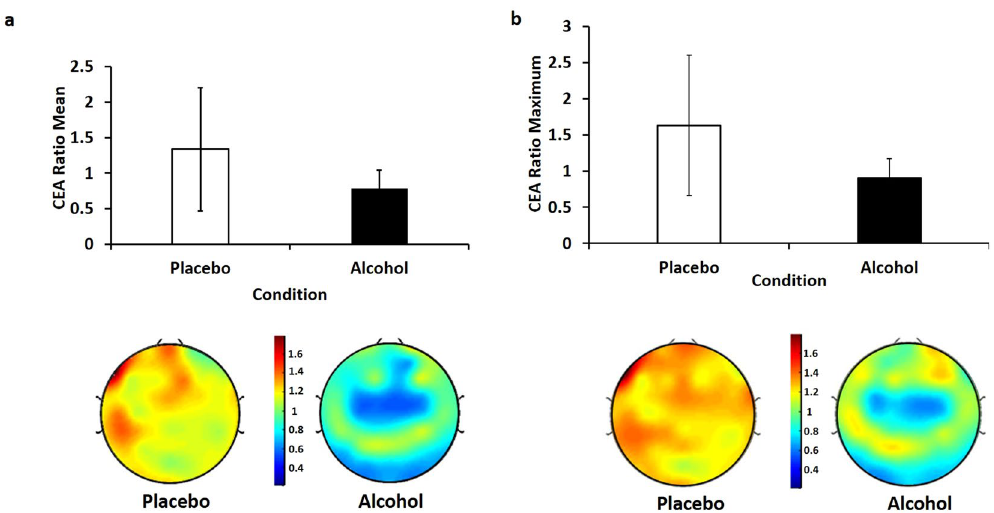
Figure 3. ( a ) Mean ratio of 100 TMS pulses to the DLPFC across all post-PAS timepoints (Post 0 min, Post 15 min, Post 30 min, Post 60 min) to 100 TMS pulses to the DLPFC pre-PAS for the placebo (white bar) and alcohol(black bar) conditions (n = 14). Error bars represent the standard deviations. Alcohol significantly impaired mean PAS-induced neuroplasticity. ( b ) Mean ratio of 100 TMS pulses to the DLPFC at time point of maximum potentiation compared to 100 TMS pulses to the DLPFC pre-PAS for the alcohol(black bar) and placebo (white bar) conditions (n = 14). Error bars represent the standard deviations. Alcohol significantly impaired maximal PAS-induced neuroplasticity. The panels on the bottom represents average topoplots of alcoholcompared to placebo, with hotter colours representing greater CEA following